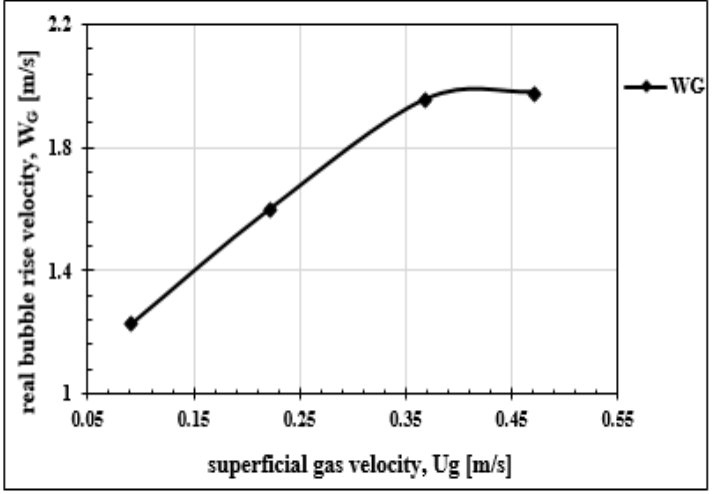
Figure 9. Relationship between bubble rise velocity and superficial gas velocity.